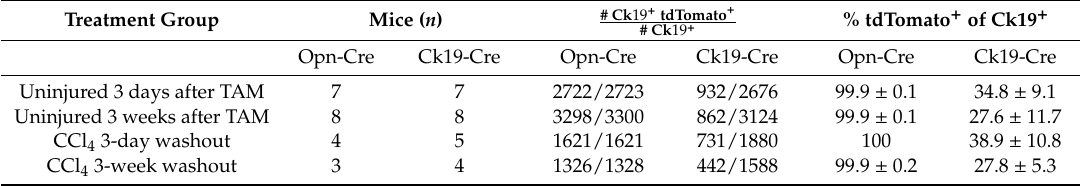
Table 1. Quantification of tdTomato +